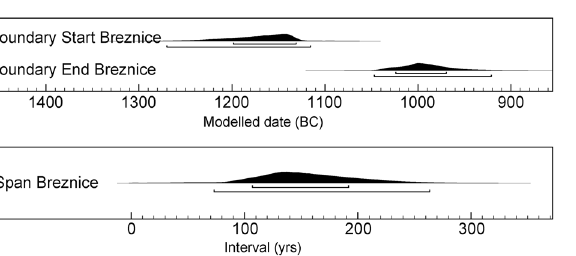
Figure 3. Probability distributions for the start, end, and overall span of Březnice site (A model = 91.1%. The model was created in OxCal v4.4. software (Bronk Ramsey 2021) using the IntCal20 atmospheric curve (Reimer et al.